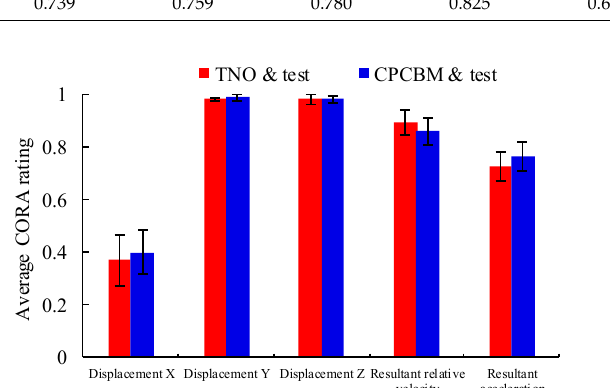
Figure 7. Average correlation and analysis (CORA) ratings of the correlations between the experimental results and the simulations using the TNO model and CPCBM, for all the analyzed signals. Table 3. Detailed CORA rating scores (S cora ) between simulations and experimental results.